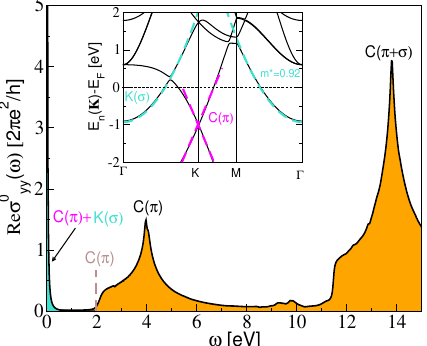
Figure 2. The ab initio optical conductivity (cid:60) σ 0 yy in the KC 8 -SL. The intraband σ intra and the interband σ inter contributions are turquoise and orange shaded, respectively. The insert shows the KC 8 -SL band structure. Turquoise dashed lines show the parabolic fit of the K( σ ) band for the effective mass m ∗ = 0.92. Magenta dashed lines denote the graphene